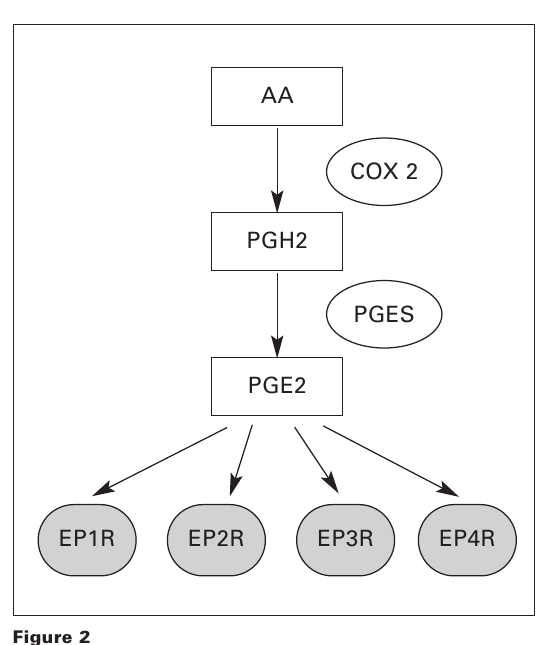
interleukin-1 b induction of prostaglandin e2 signalling. il-1 b induces the production of prostaglandin e2 (PGe2) through the action of its signalling receptor heterodimer il-1R1/il- 1R1AcP and the subsequent activation of NF- k B and induc- tion of COX-2. COX-2 is highly inducible, whereas COX-1 is ubiquitously expressed [120]. COX-2 catalyses the conver- sion of the membrane lipid arachidonic acid (AA) to prostaglandin H2 (PGH2). PGH2 is converted into prostaglandin e2 (PGe2) by terminal PGe synthase (PGeS). PGe2 signals through four different G-protein coupled receptors, eP1R–eP4R, which occur in several isoforms [52,